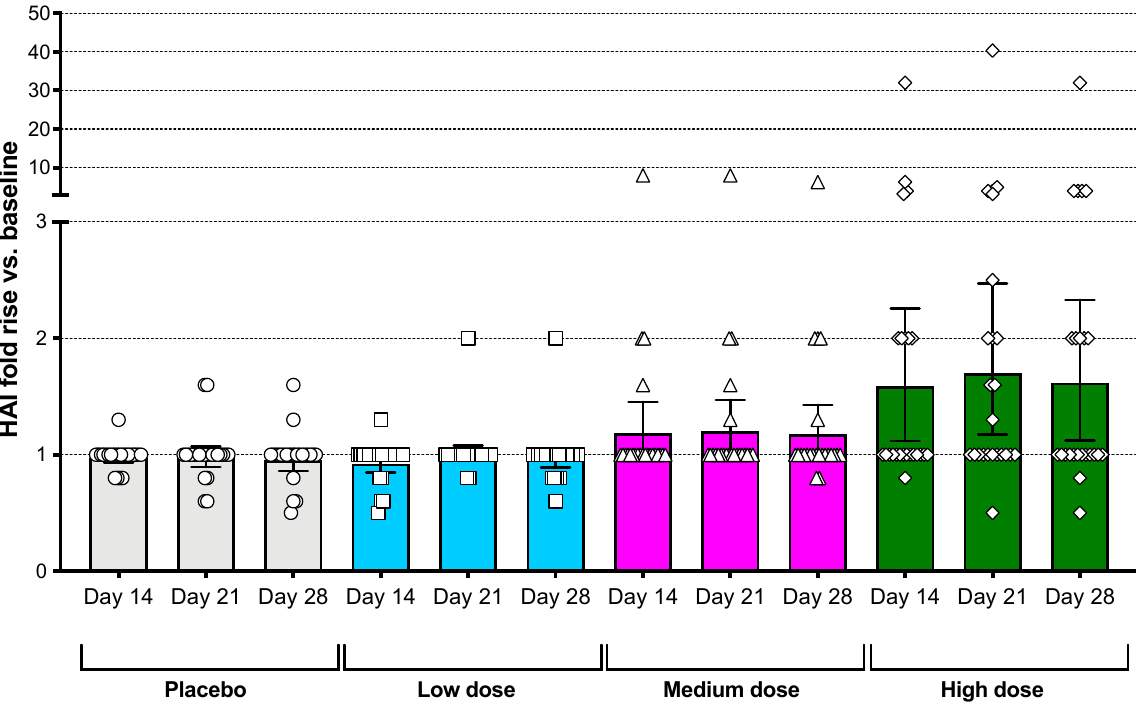
Figure 2. Serum HAI dose response against A/Brisbane/10/2007 virus. HAI titer fold increase vs. baseline is shown for subjects in the four different groups at days 14, 21 and 28. Bars represent the geometric mean with error bars showing the 95% confidence interval. Mean HAI titers at baseline ranged from 15 to 25. Table 2. Day 28 HAI responses rates after high-dose vaccination. Placebo High Dose